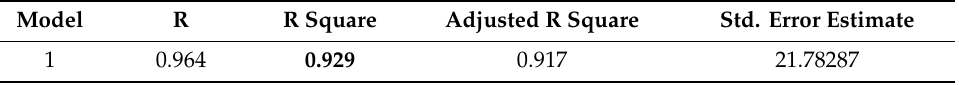
Table 5. The result of Multiple Regression Analysis for parameters from the Fuel Imports group.